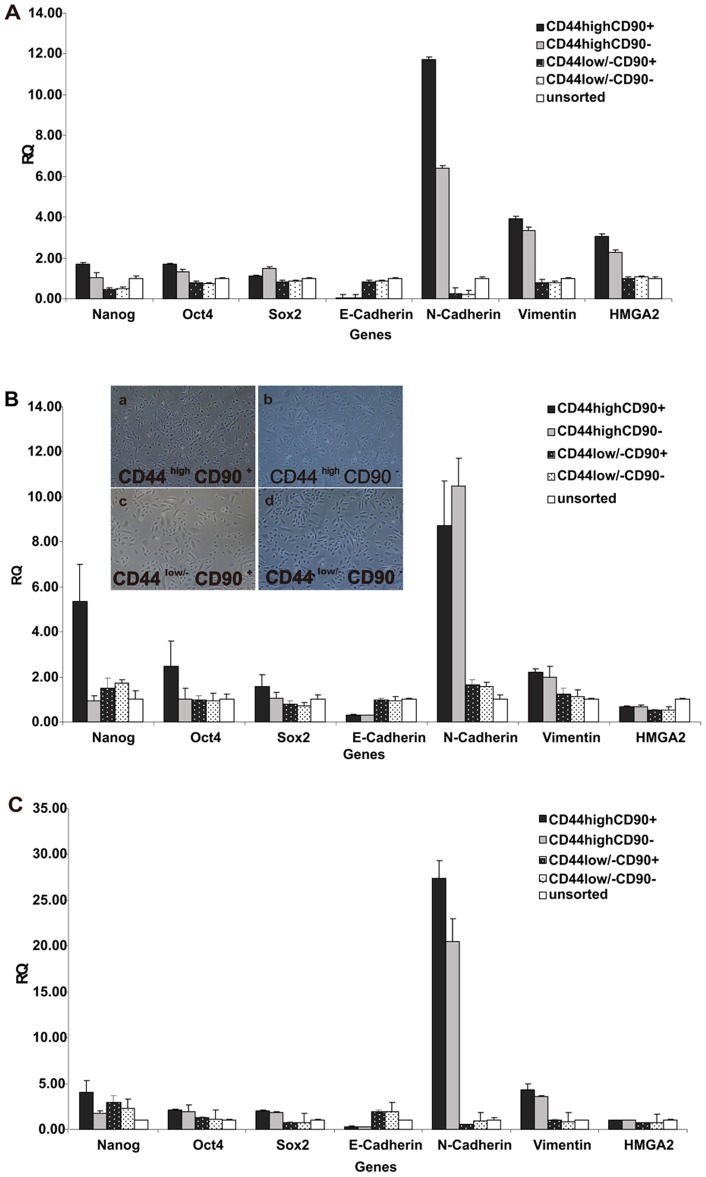
Analysis of the expression of stem cell and EMT related genes in different sub-populations from the PLCCLs.Detectable expression levels of the genes were found in all sorted sub-populations from the cell lines LC004 (A), LC006 (B) and LC021 (C). PCR reaction without template served as a negative control. The relative expression of target genes was related to the expression of PGK1 and normalized to the unsorted control cells. X axis shows the target genes, Y axis shows the relative expression level (RQ). The error bars reflect the variation within the triplicates, P<0.05. (B). The FACS sorted cell sub-populations derived from the cell line LC006 were cultured in the serum-free culture system for 1–2 weeks and revealed different cell morphology for different sorted sub-populations: (a) CD44highCD90+ cells; (b) CD44highCD90− cells; (c) CD44low/−CD90+ cells, and (d) CD44low/−CD90− cells. Photomicrograph magnification, ×200.